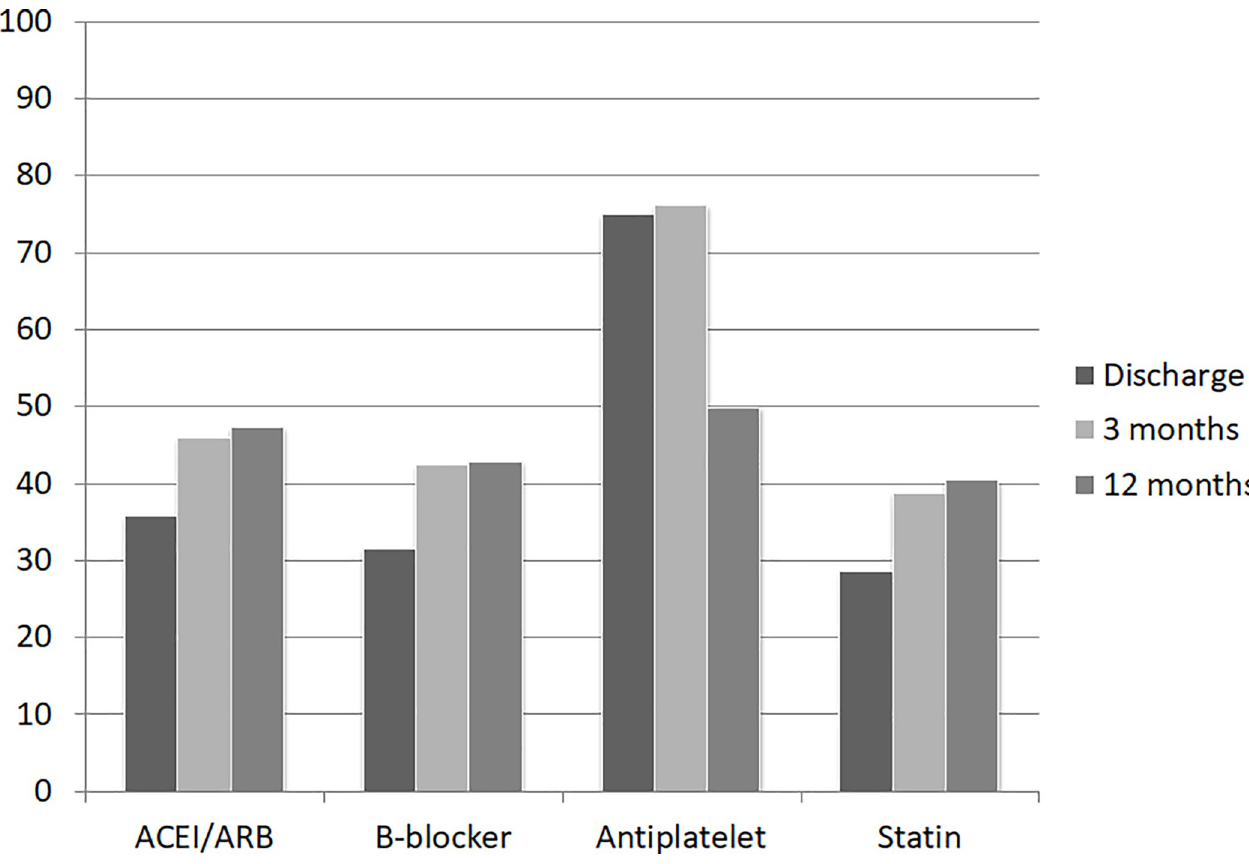
Fig 2. Trend in prescription changes over 1